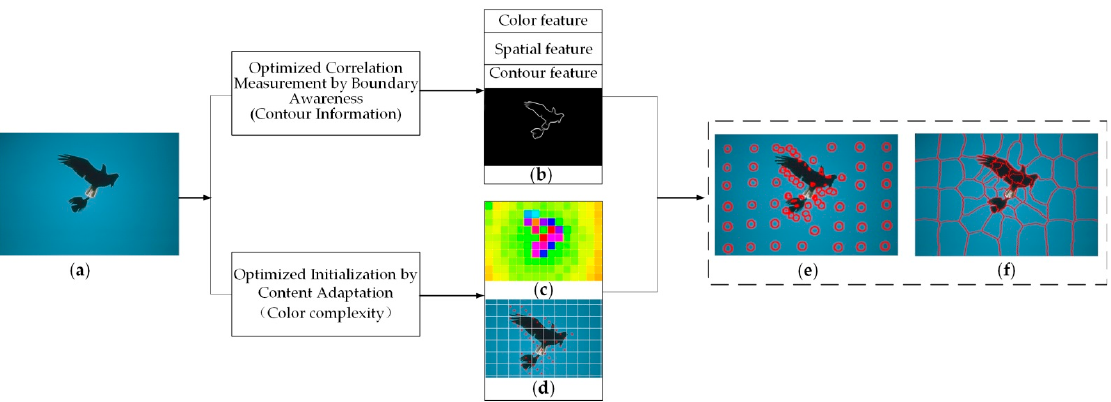
Figure 2. Schematic illustration of BACA superpixel generation framework. ( a ) Input image; ( b ) Contour map prior; ( c ) Diagram of color intensity; ( d ) Optimized seeds initialization by content complex- ity, wherein the complexity of content is represented by color feature; ( e ) The intermediate process of region growth; ( f ) Result of BACA